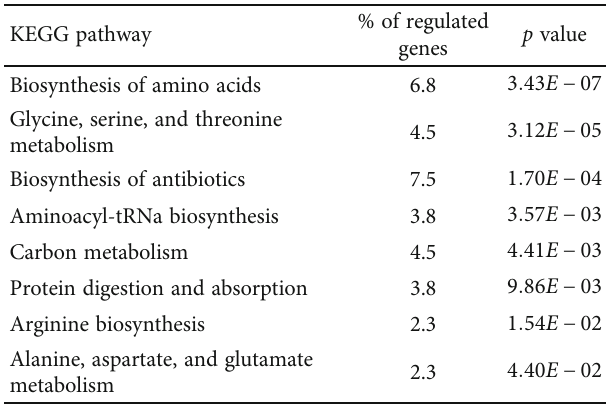
Table 1: Pathway enrichment analysis of genes signi fi cantly regulated by dexamethasone and